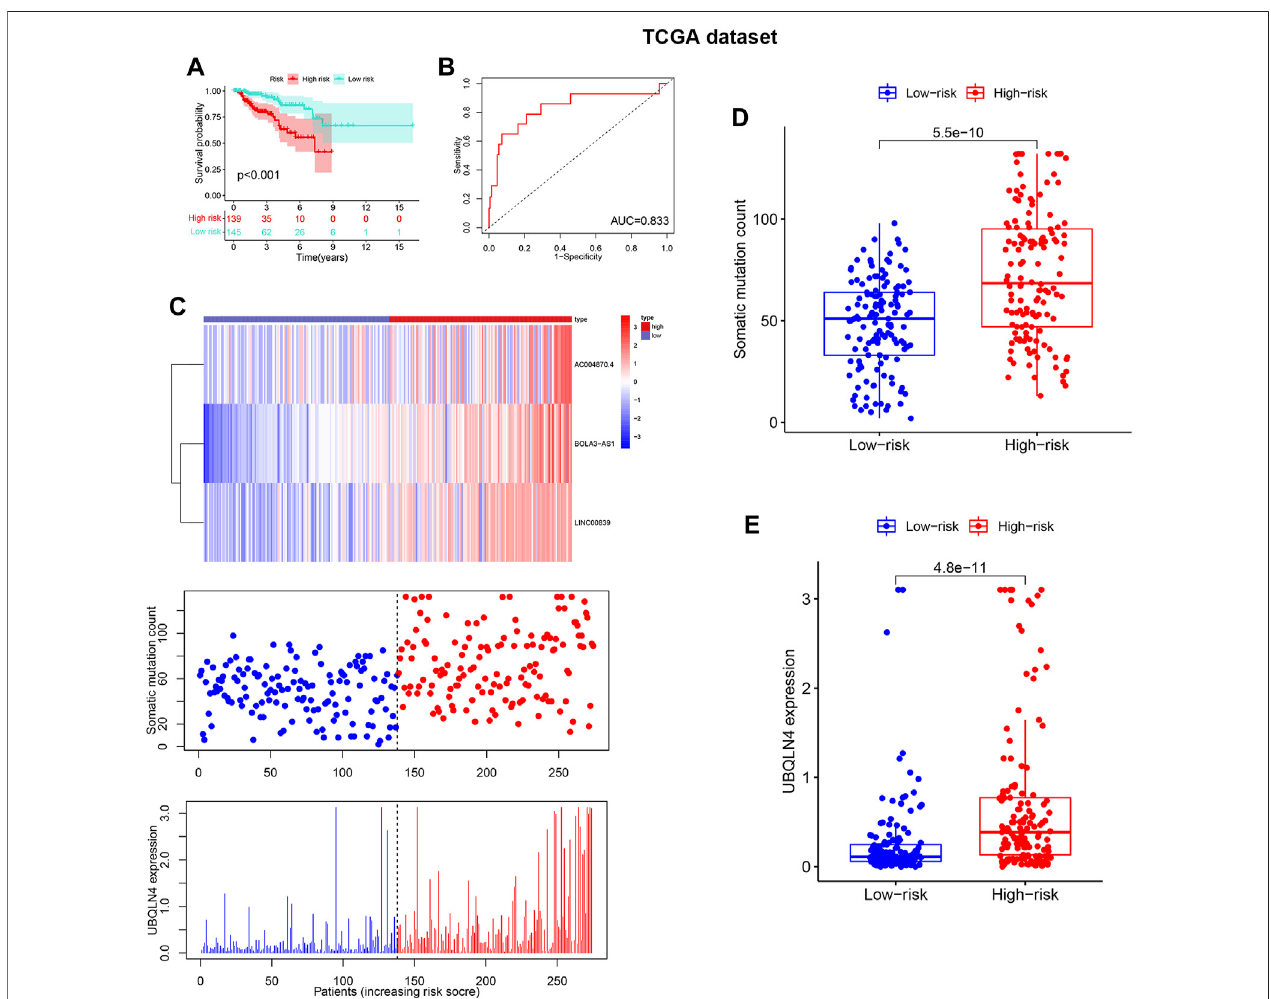
FIGURE 6 | Veri fi cation of the GILncSig in the Cancer Genome Atlas (TCGA) datasets. (A) . Kaplan – Meier survival curves of GILncSig in the TCGA dataset. (B) . ReceiveroperatingcharacteristiccurvesofGILncSigat3yearsintheTCGAdataset. (C) .ThedistributiontrendofsomaticmutationandUBQLN4expressionincreasedin correlation with rising GILncSig in the TCGA dataset. The number of somatic mutations between the risk hi and risk lo groups and the expression level of UBQLN4 in the risk hi and risk lo groups (D,E) .